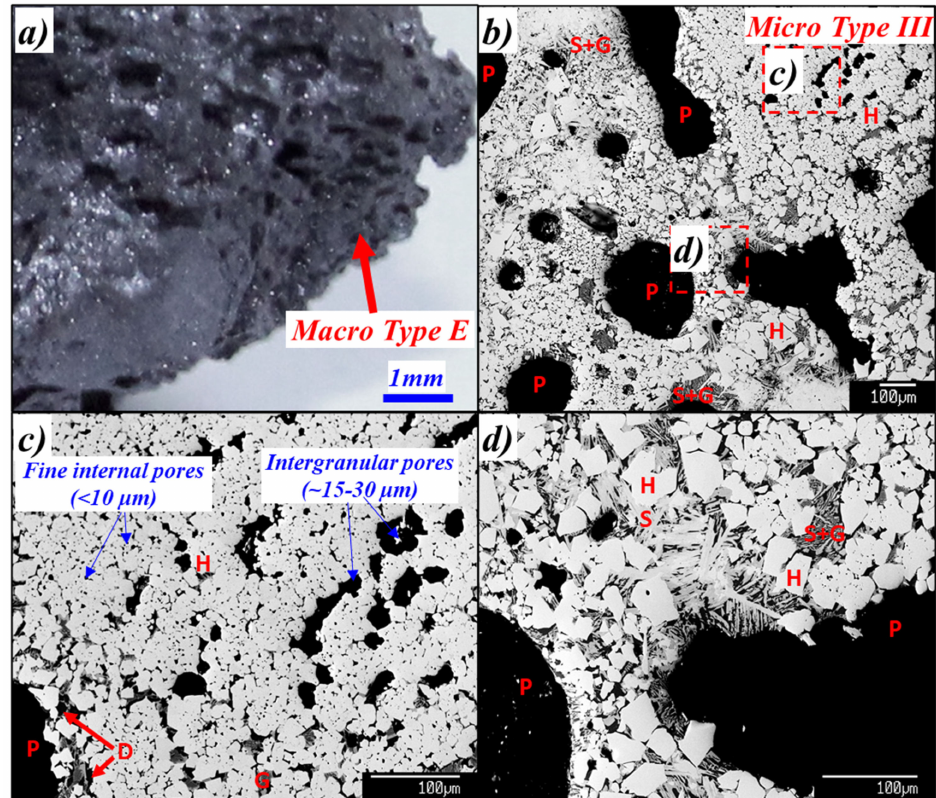
Figure 8. ( a ) Details of macro-features of type E (shiny/fractured surface fine pores) taken by digital camera; ( b ) overview of the microstructure in Macro-Type E; ( c , d ) details from different locations of ( b ), G = Glass; H = Hematite; S = SFCA solid solution; D = Dicalcium silicate (C 2 S); P =